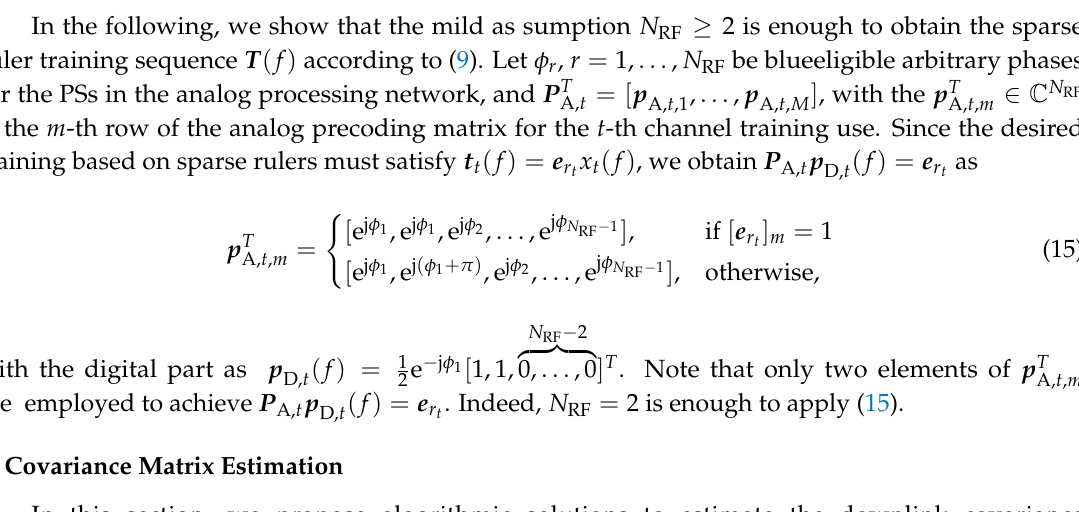
Figure 1. Training length vs. number of antennas with Wichmann rulers. Dashed lines show as ymptotic upper and lower bounds on the minimum training size based on